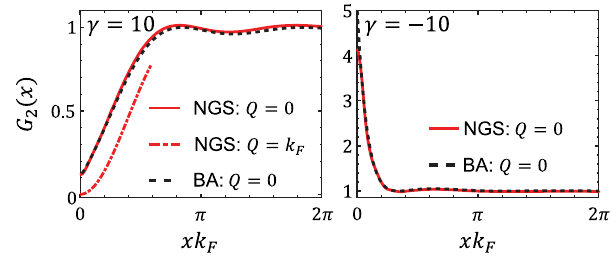
FIG. 5. Comparison of the two-point static correlation function G 2 ð x Þ : solid (red) curves correspond to the non-Gaussian variational approach; dashed (black) lines represent the BA analytical results adopted from Refs. [42,43]. We consider both repulsion (left) and attraction (right). Parameters used are Λ ¼ 15 k and N ¼ 51 . F